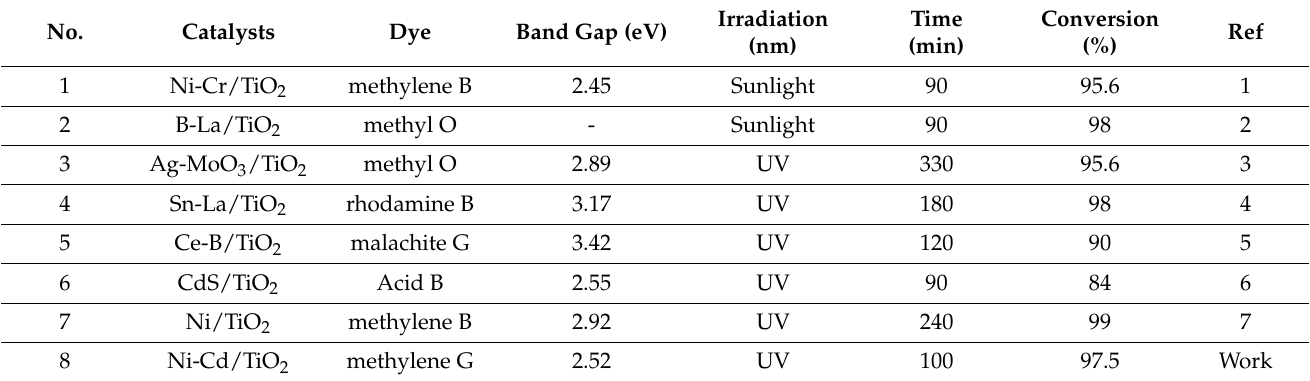
Table 2. Comparative analysis of the synthesized catalysts with the reported studies.